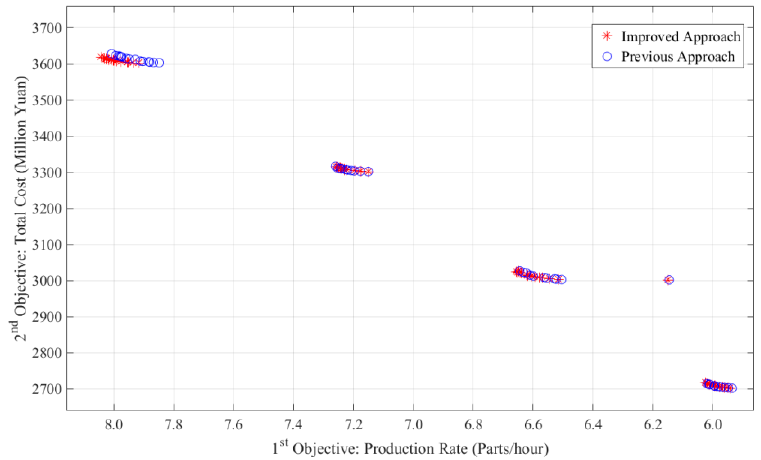
Figure A2. Comparison for Case B: results from the optimal sets of the additional runs.